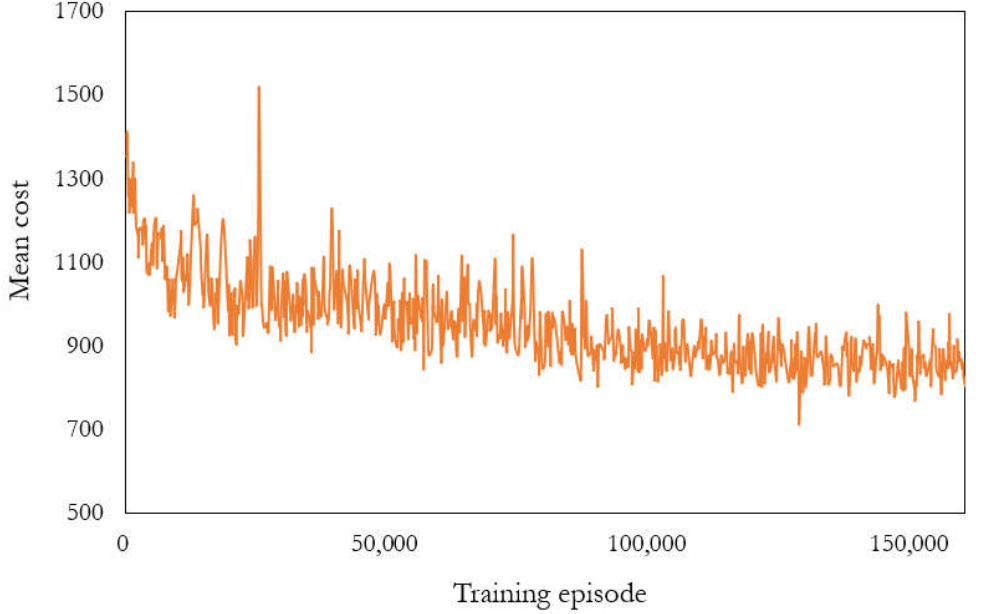
Figure 7. Mean of cost for the last 100 training episodes for discount factor = 0.1.